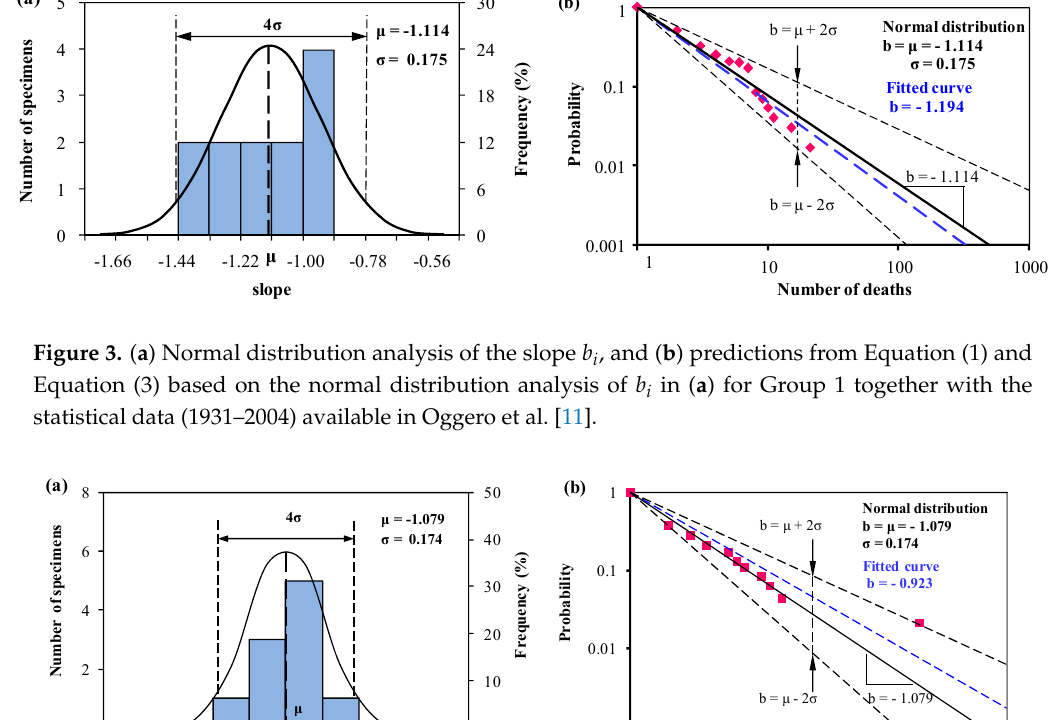
Figure 3. ( a ) Normal distribution analysis of the slope b i , and ( b ) predictions from Equation (1) and Equation (3) based on the normal distribution analysis of b i in ( a ) for Group 1 together with the statistical data (1931–2004) available in Oggero et al. [11].